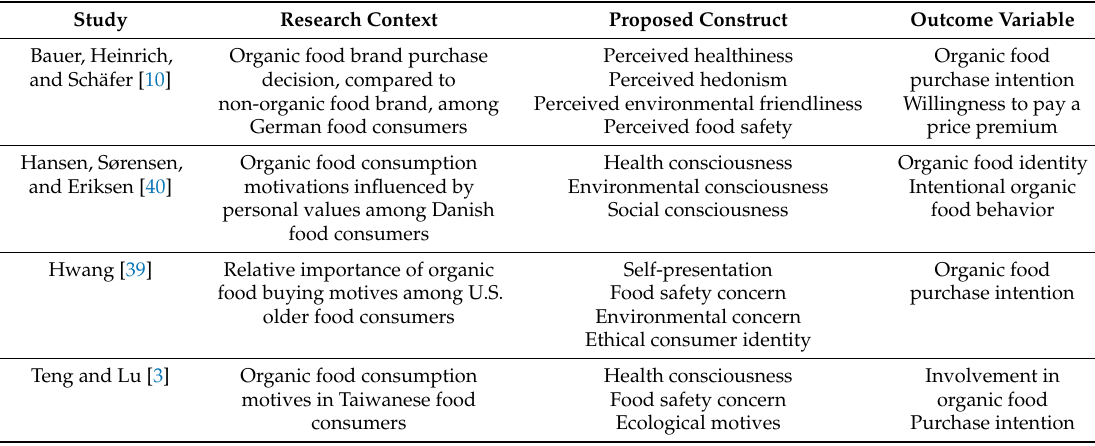
Table 1. Summary of constructs of the motives for healthy food consumption in previous